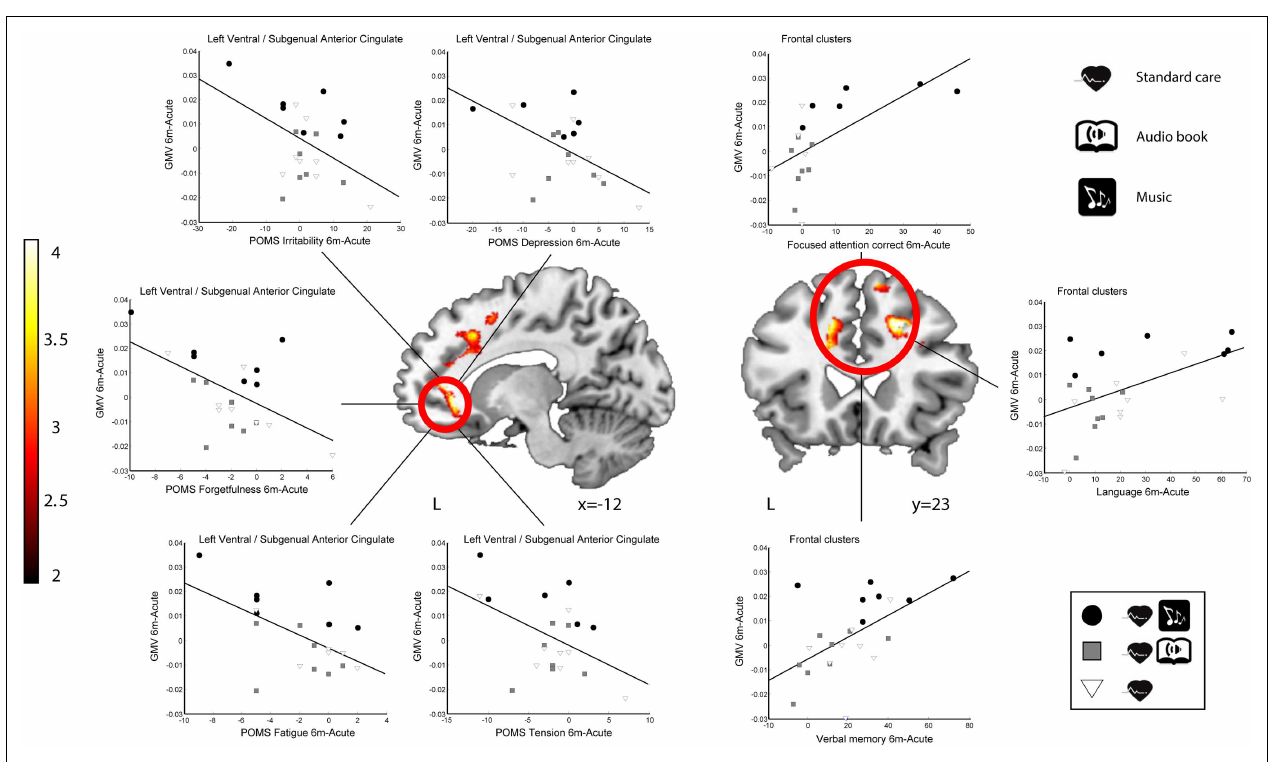
cluster) and cognitive variables (three frontal clusters pooled together). Neurological convention is used. Results are shown at p < 0.01 (uncorrected) with ≥ 50 voxels of spatial extent and overlaid over a canonical template with MNI coordinates at the bottom right of each slice (see also Table 6 ). L, left